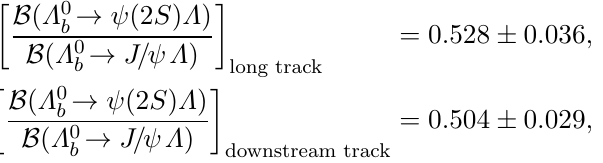
Figure 3 . Fits to the weighted invariant-mass distributions of long-track candidates for (a) (cid:3) 0 (2 S ) (cid:3) and (b) (cid:3) 0 ! J= (cid:3) and for downstream-track candidates for (c) (cid:3) 0 b (cid:3) 0 ! J= (cid:3) candidates. The signal (blue, dashed), the combinatorial background (green, dotted), b the B 0 ! K 0 background (cyan, long-dash-dotted) and the (cid:4) (cid:0) S dash-triple-dotted) are